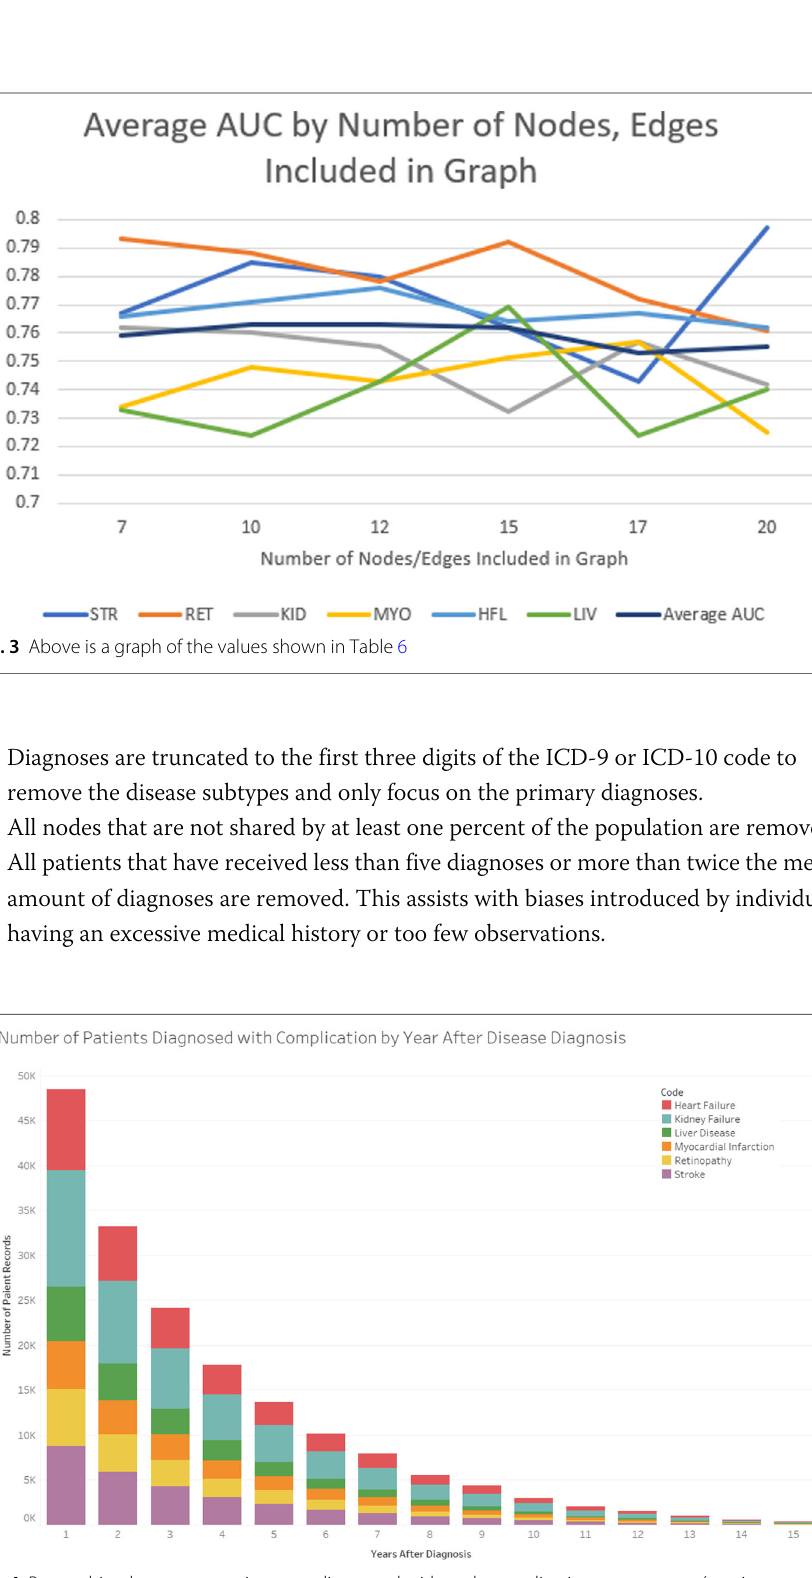
Fig. 4 By graphing how many patients are diagnosed with each complication rate per year (starting one year after a diabetes diagnosis), we can see that most patients develop complications quickly. We want to identify what will delay complication onset by comparing the patients who are slow and fast progressors, with the fast progressors occupying the left hand side of the chart. Abbreviations: Myocardial infarction (MYO), Heart failure (HFL), Kidney disease (KID), Liver disease (LIV), Retinopathy (RET), Stroke